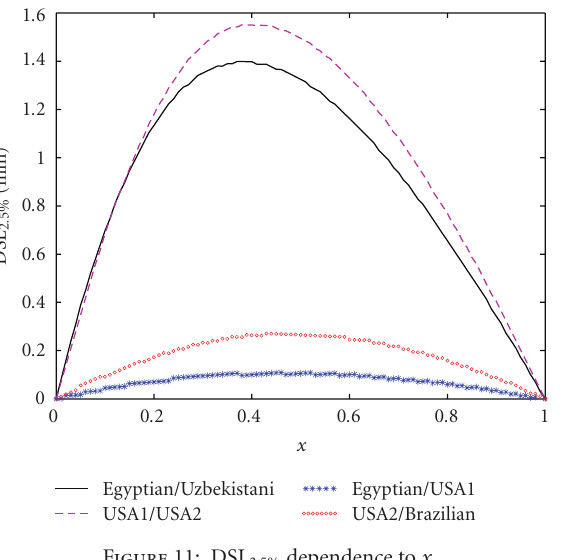
Figure 11: DSL 2 . 5% dependence to x .